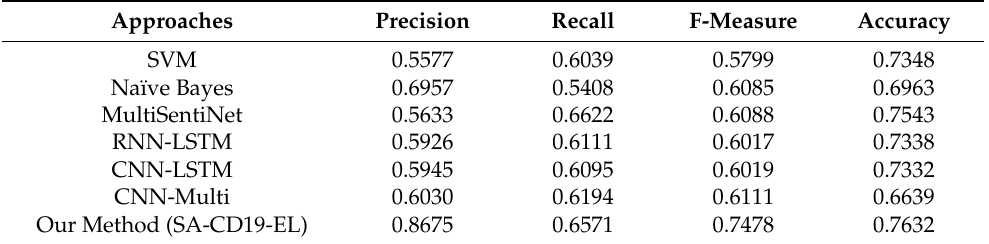
Figure 10. The percentages of the polarity (very positive, positive, neutral, negative, and very neg- ative) labels are connectivity based on vaccines, and each color represents a label. Table 4. The final results compared between (SA-CD19-EL) and other methods for the fake news dataset. Approaches Precision